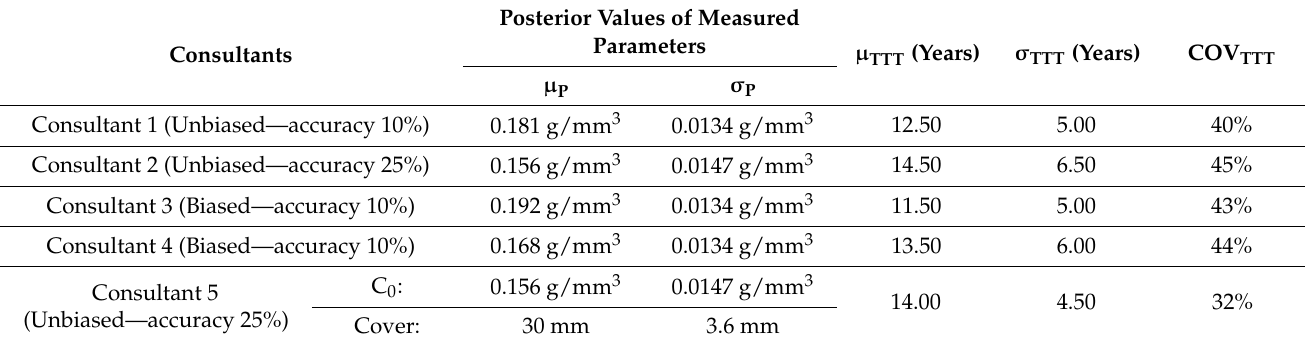
Table 9. Pre-posterior analysis for choosing inspection method and corresponding expected time to transition (TTT).